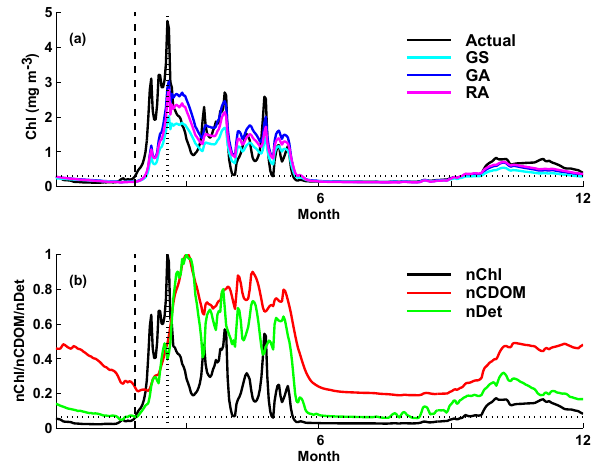
Figure 8. Illustrative example time series for 1 year from a single location in the North Atlantic (shown as o on Fig. 9). (a) “actual” Chl a (black), derived Chl a using subsampled output (GS, light blue), derived Chl a using all output (GA, dark blue) and the Chl a product derived using a region-specific algorithm (RA, purple). (b) actual Chl a (black), CDOM (red) and detritus (green), all nor- malized to their peak value. The dashed vertical line indicates the “initiation of the bloom” which is taken to be when Chl a reaches 5% above the annual median value following Cole et al. (2012) and discussed further in Appendix A (dotted horizontal line shows this value for the model actual Chl a ). The vertical dotted line indicates the timing of the peak of the bloom. Shown here is only a single year and location but for a larger scale perspective, the difference in initiation and peak timing between model actual and derived Chl a averaged over all years are shown for the globe in Fig.